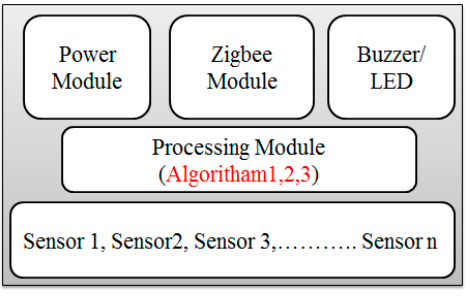
Figure 5. Sensing Module.